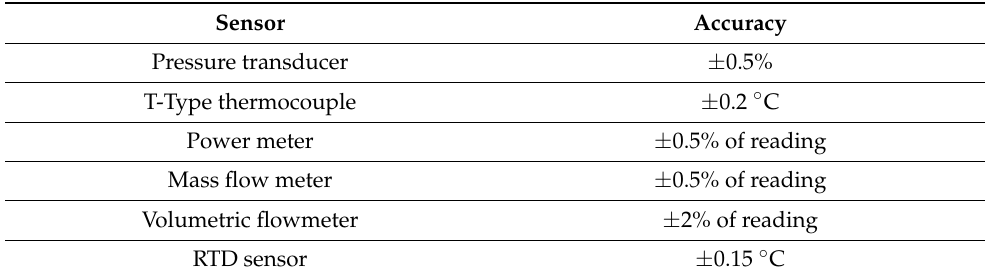
Table 2. Sensors and their